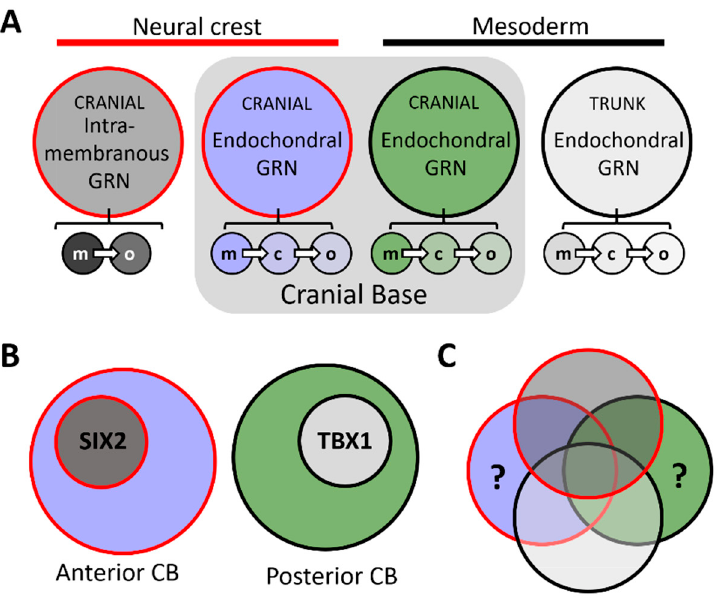
Figure 4. ( A ) Diagram representing hypothetical gene regulatory networks (GRNs) for neural crest intramembranous (red outline, dark grey fill), neural crest endochondral (red outline, light blue fill), cranial mesoderm endochondral (black outline, green fill), and trunk mesoderm endochondral (black outline, light grey fill) modes of ossification. Note, while each large circle represents a collective of GRNs, these processes could be broken down into cell-type specific GRNs, including ‘mesenchymal precursor’ (m), chondroblast/cyte (c), and osteoblast/cyte (o)—represented by the small circles in A. ( B ) The prevailing notion would suggest that anterior or posterior cranial base GRNs are composed of reutilized GRN ‘modules’ from other tissues. For example, the anterior cranial base ‘SIX2 module’ [52] is the same that is used in neural crest derived viscerocranial elements. Likewise, for the posterior cranial base ‘TBX1 module’ [68] and other TBX1 GRNs. ( C ) Venn diagrams conceptualizing GRN overlap between these different skeletal populations. Whether novelties exist for anterior and posterior cranial base GRNs (regions denoted by ‘?’) remains to be fully realized. Abbreviations: c, chondroblast/cyte; CB, cranial base; GRN, gene regulatory network; m, mesenchymal precursor; o,